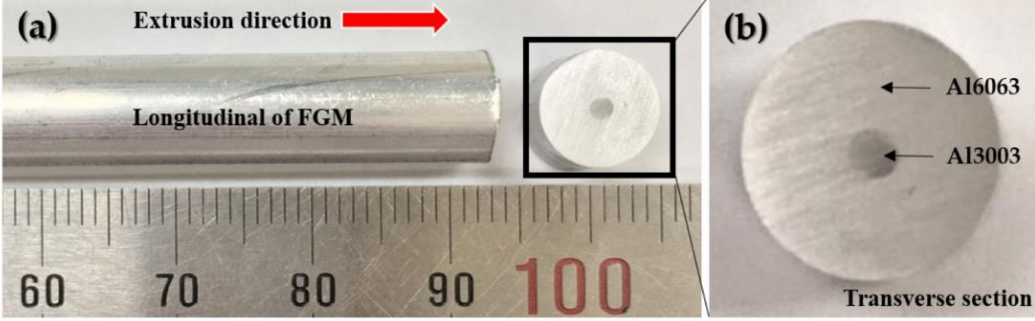
Figure 4. Al3003/Al6063 functionally graded materials (FGMs) fabricated via hot extrusion: ( a ) Photograph of the FGMs and ( b ) high-magnification image of the cross-section of Al3003/Al6063